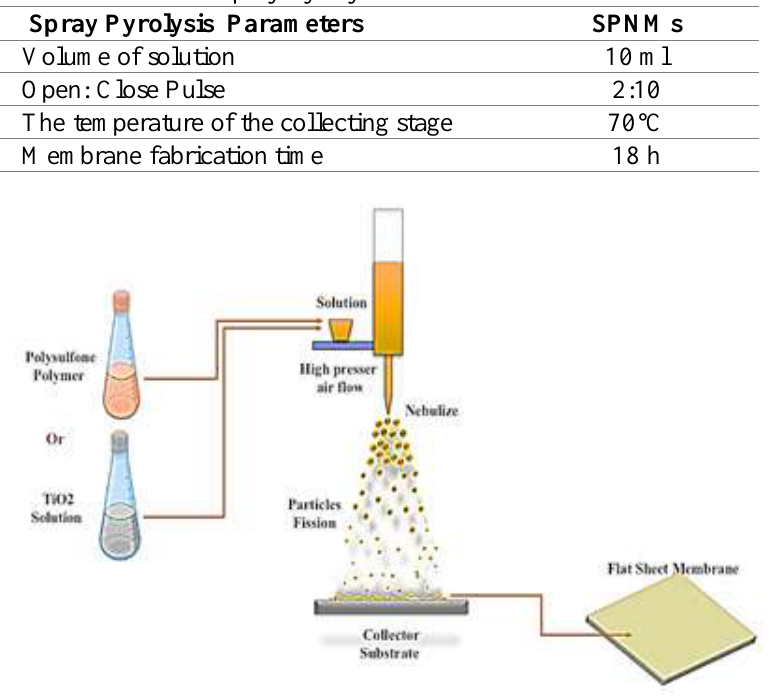
Figure 2: diagram of Polysulfone membrane